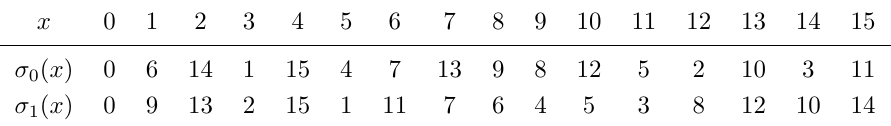
Table 1: The lookup tables of the S-boxes we use.